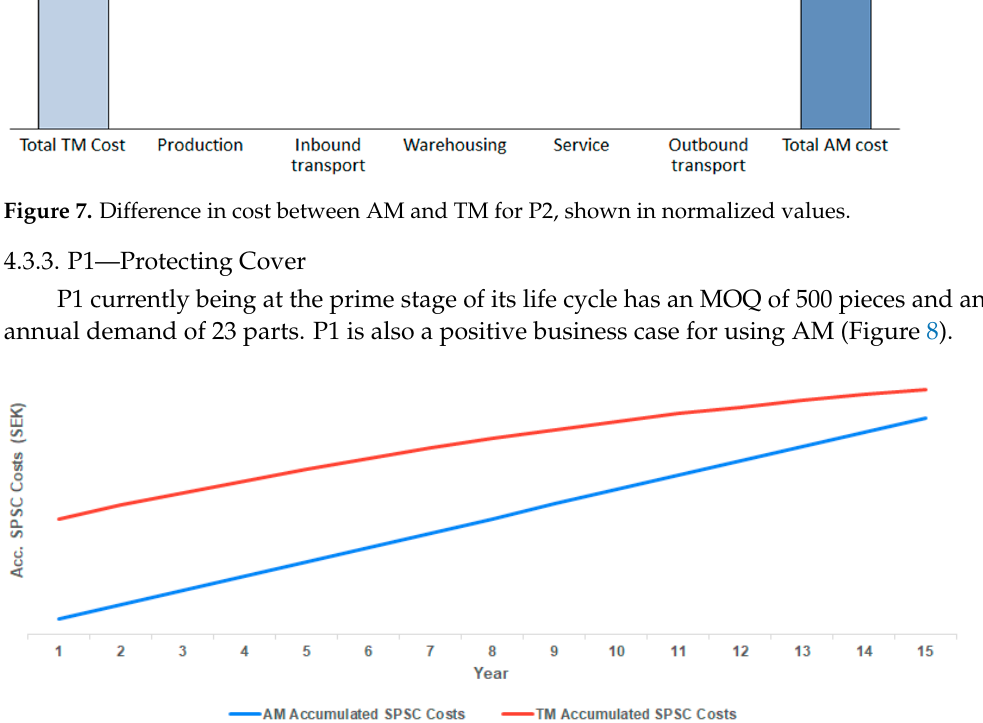
Figure 9. Difference in cost between AM and TM for P1, shown in normalized values.